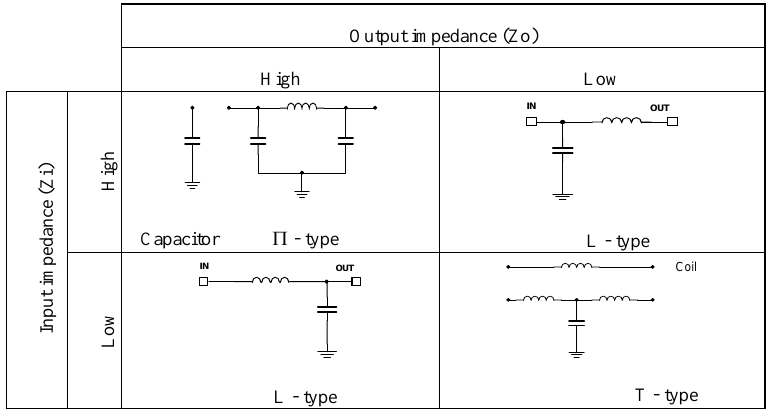
Figure 4. Selection of an appropriate EMI filter